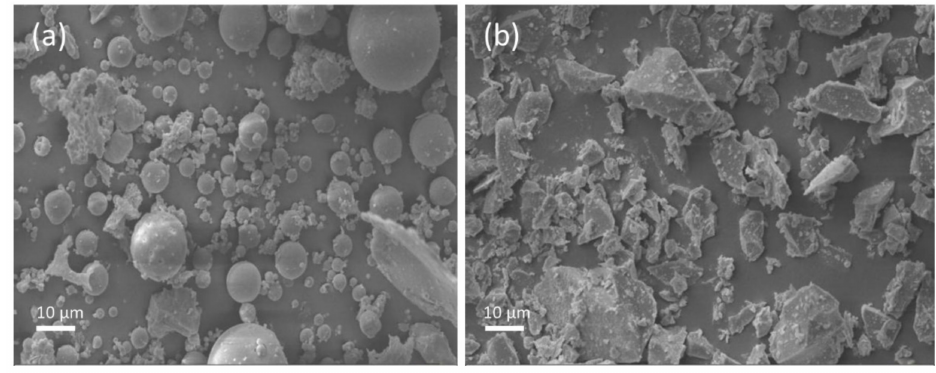
Figure 3. Morphology of the fly ash ( a ) and the slag ( b ).